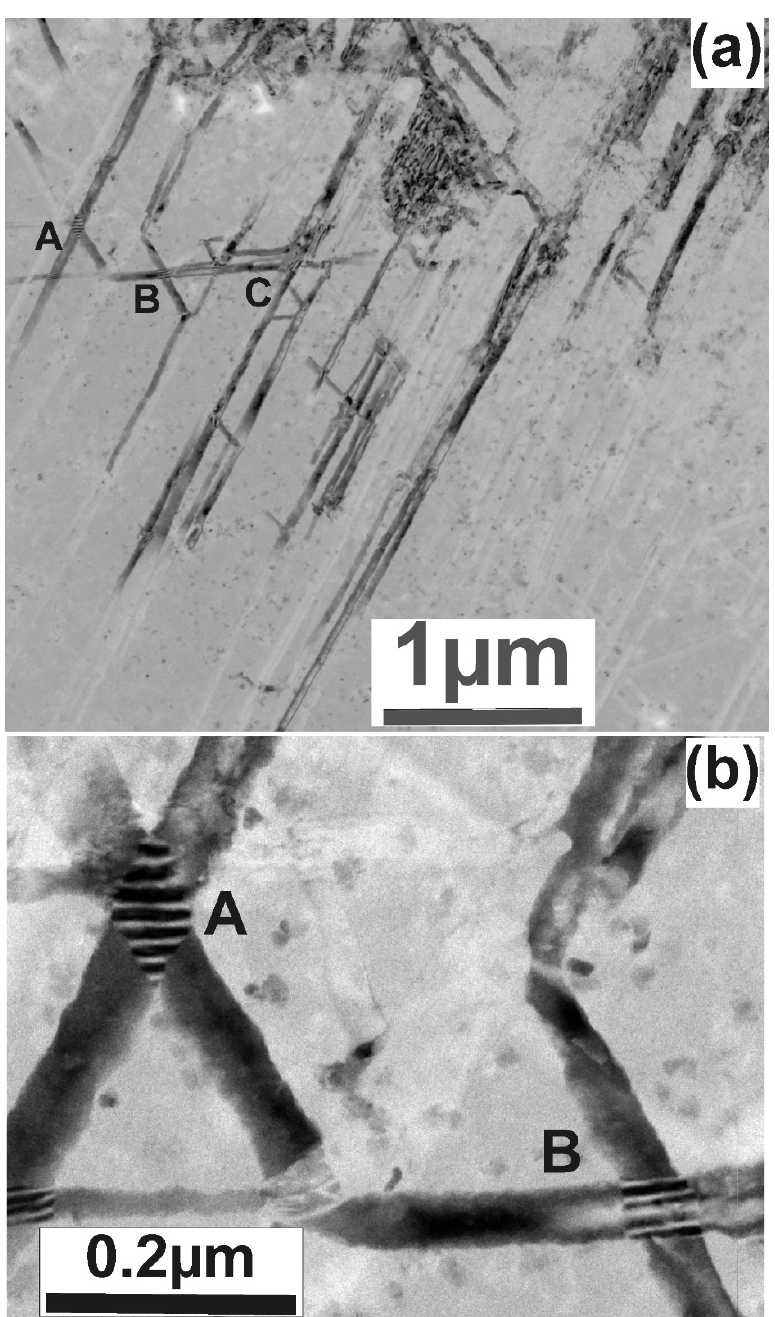
Figure 4. TEM micrographs. ( a ) Overall view of crossing whiskers; in some cases, the same whisker crosses several whiskers having different orientations denoted by the letters A, B and C. ( b ) The crossing areas A and B at higher magnification reveal the formation of Moiré fringes.